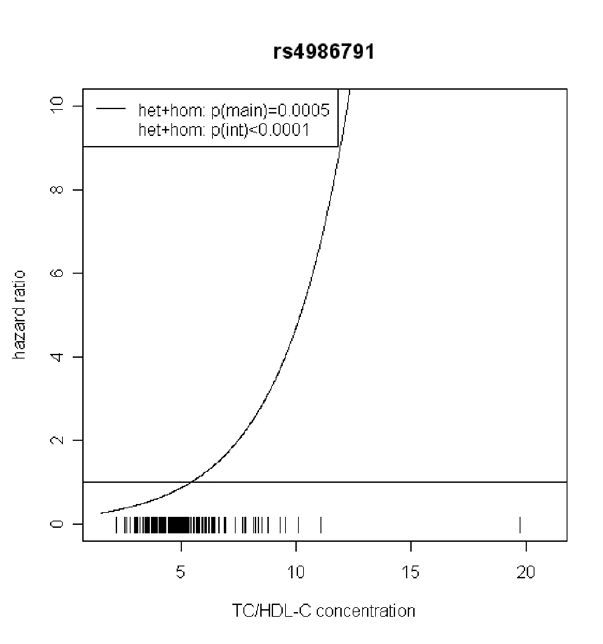
Figure 6 Hazard ratios of incident type 2 diabetes related to the respec- tive TC/HDL-C concentration in men for rs4986791 . Continuous lines represent subjects who are heterozygote or homozygote for the minor allele. Small bars at the x-axis indicate TC/HDL-C concentrations of patients with at least one copy of the minor allele.